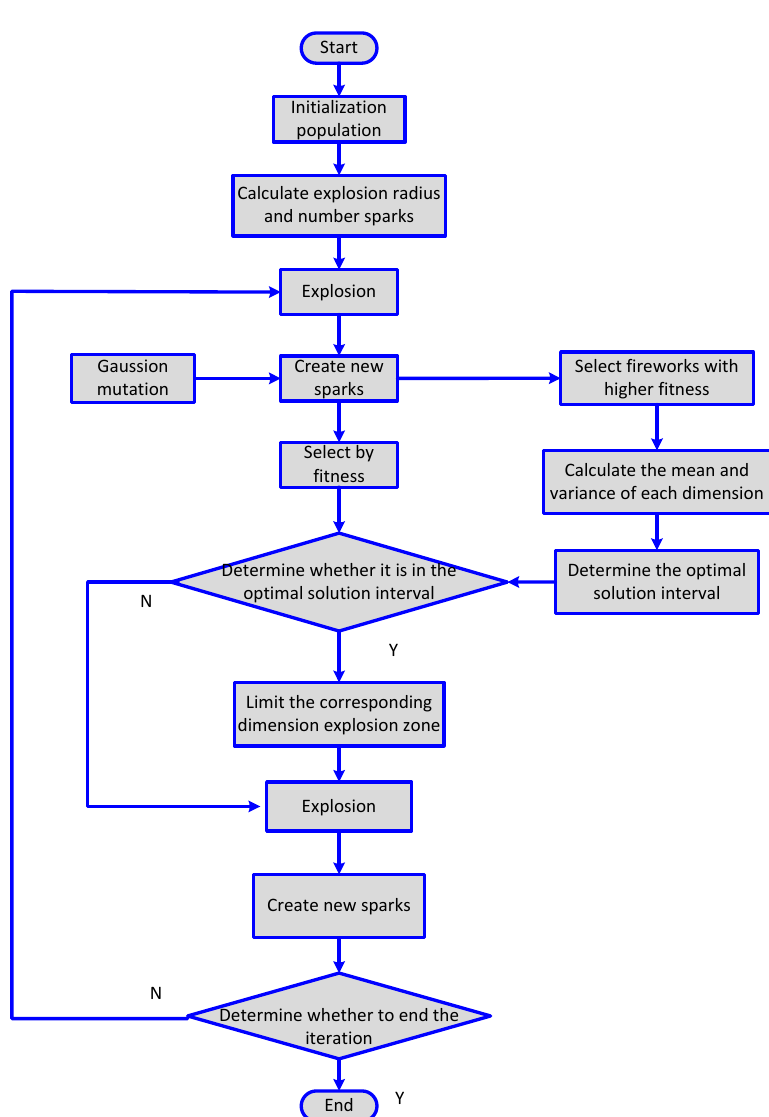
Figure 1. The flow chart of improved fireworks algorithm. 2.2. Multi-dimensional Grey Model and Grey Neural Network Model